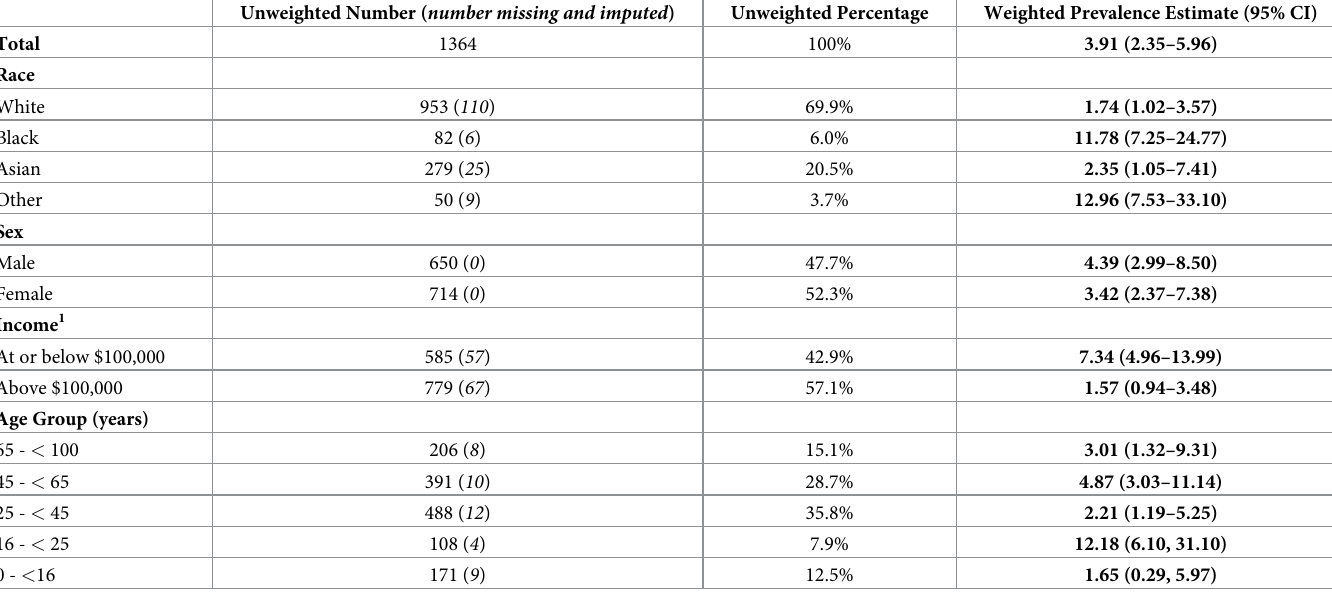
Table 4. Weighted prevalence estimates for anti-SARS-CoV-2, King County, Washington anti-SARS-CoV-2 seroprevalence survey, August 2020. Unweighted Number ( number missing and imputed )